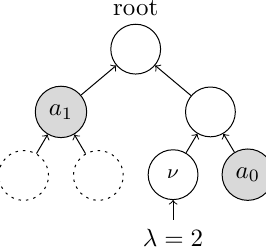
Figure 1: Example of an authentication path in a tree of four leaves. Starting from ν , the leaf indexed at λ = 2, the root can be recomputed using only auth = { a 0 , a 1 }